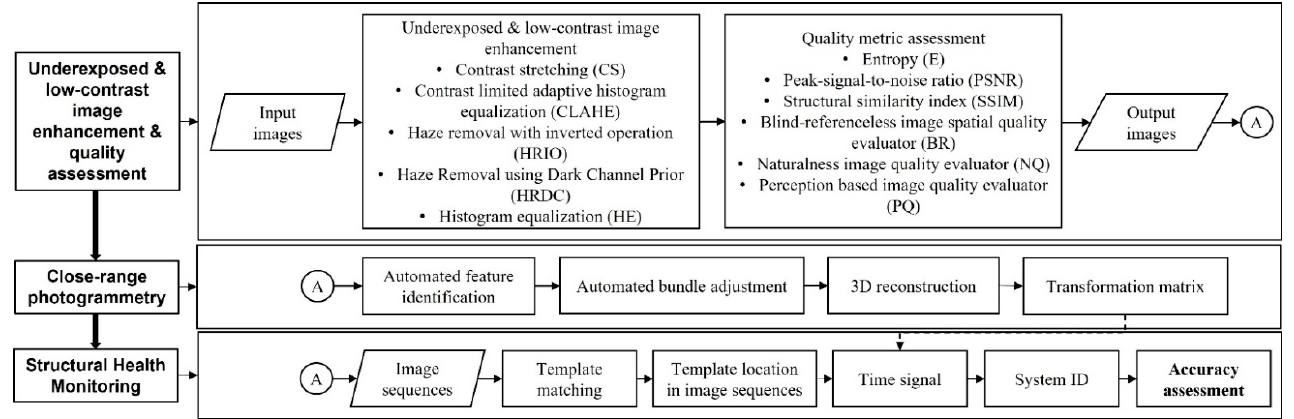
Figure 1. Proposed framework for underexposed and low-contrast image enhancement that incorporates a close-range photogrammetry procedure for application in SHM.